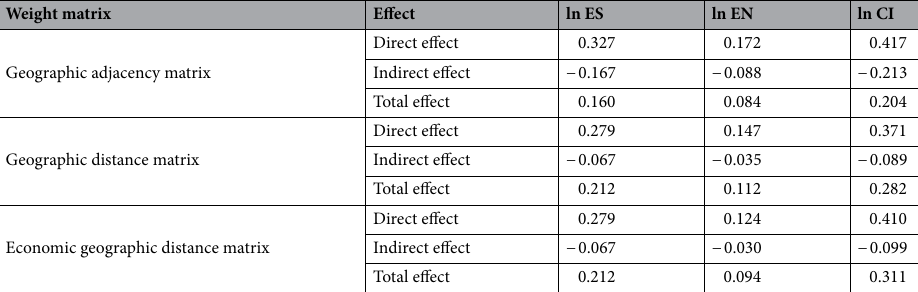
Table 7. Spatial spillover effect of emergency capacity. The direct effect, indirect effect and total effect can be obtained by decomposing the spatial spillover effect of the parameters listed in SDM model. Among them, direct effect refers to the influence brought by local parameters, while indirect effect refers to the influence brought by parameters from adjacent areas. The total effect is the sum of the two effect values above 37 . Confidence level: